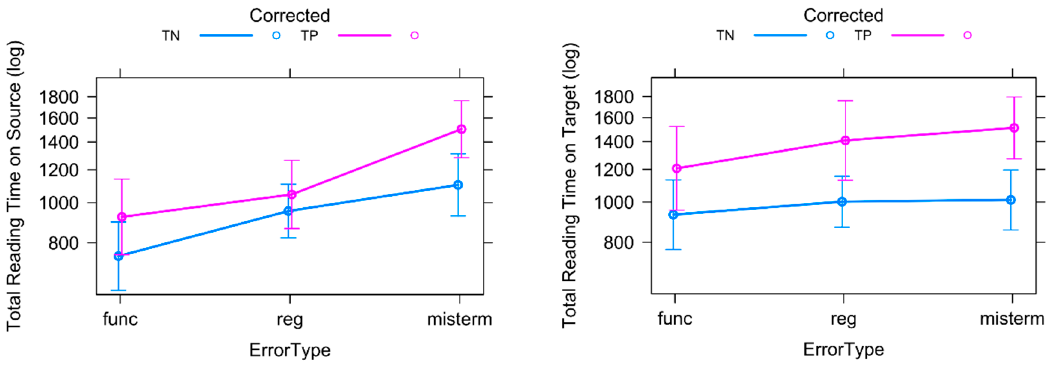
Figure 9. Effect of the interaction Corrected with Error Type on total reading times in ST ( left ) and TT ( right ).